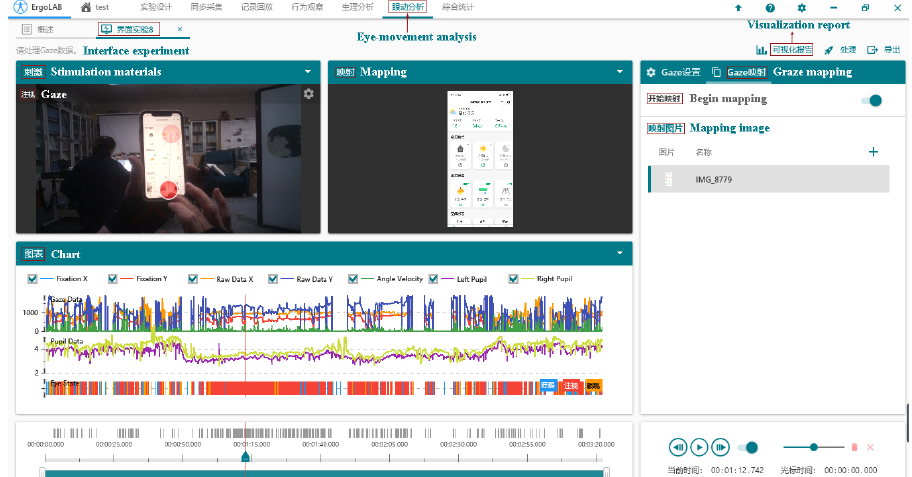
Figure 2. The platform for experimental field runs. It consists of three main windows: live video and eye movement data filmed real-time, real-time mapping of stimulus materials, and real-time monitoring of physiological sensor